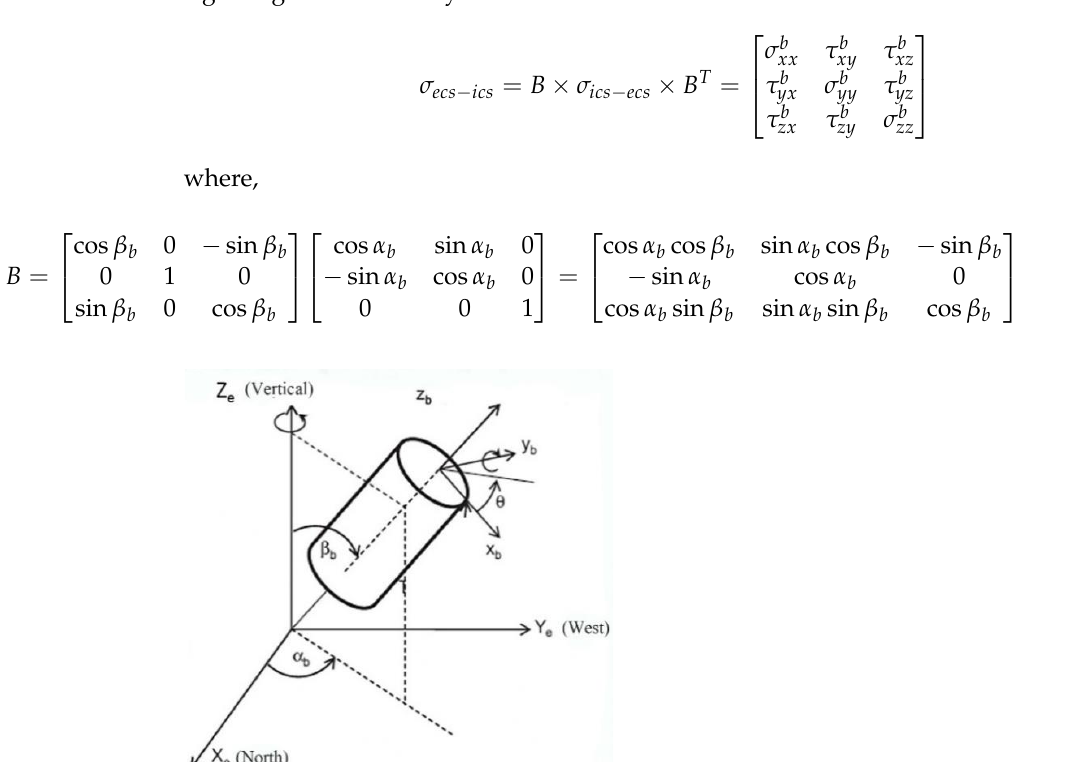
Figure 7. The conversion relationship between global coordinate system and well bore right angle coordinate system.